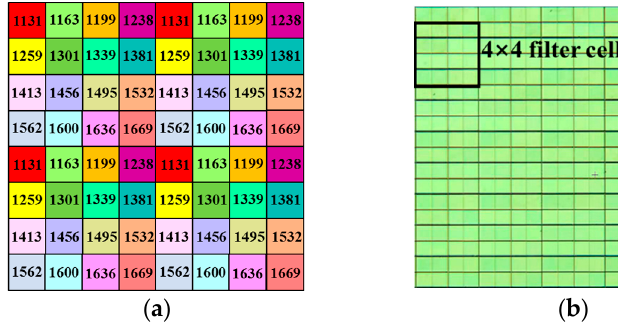
Figure 1. ( a ) Geometric pattern of the 16-channel pixel-level filter array (PFA) we selected, ( b ) microscope image of the 16-channel PFA, and ( c ) transmittance curves of the PFA.